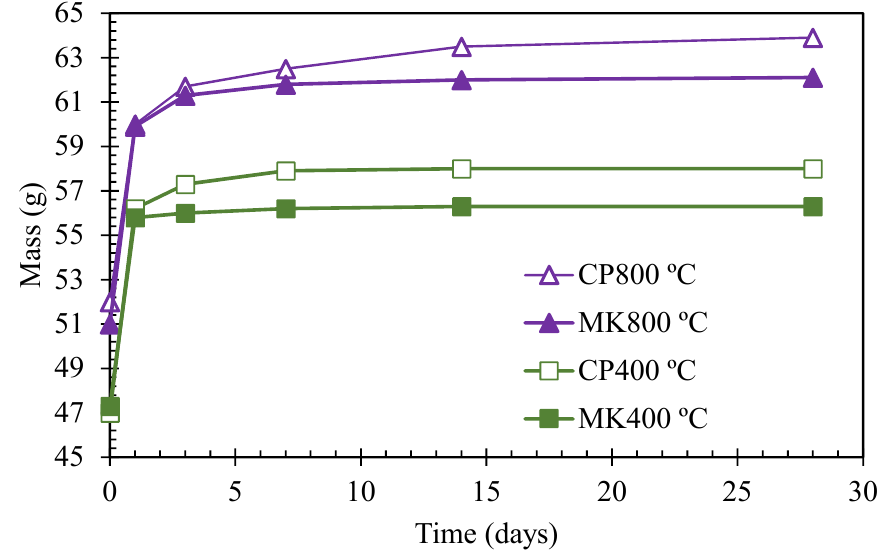
Figure 12. Mass change of cement paste and metakaolin-cement paste under the water absorption test after elevated temperature exposure.